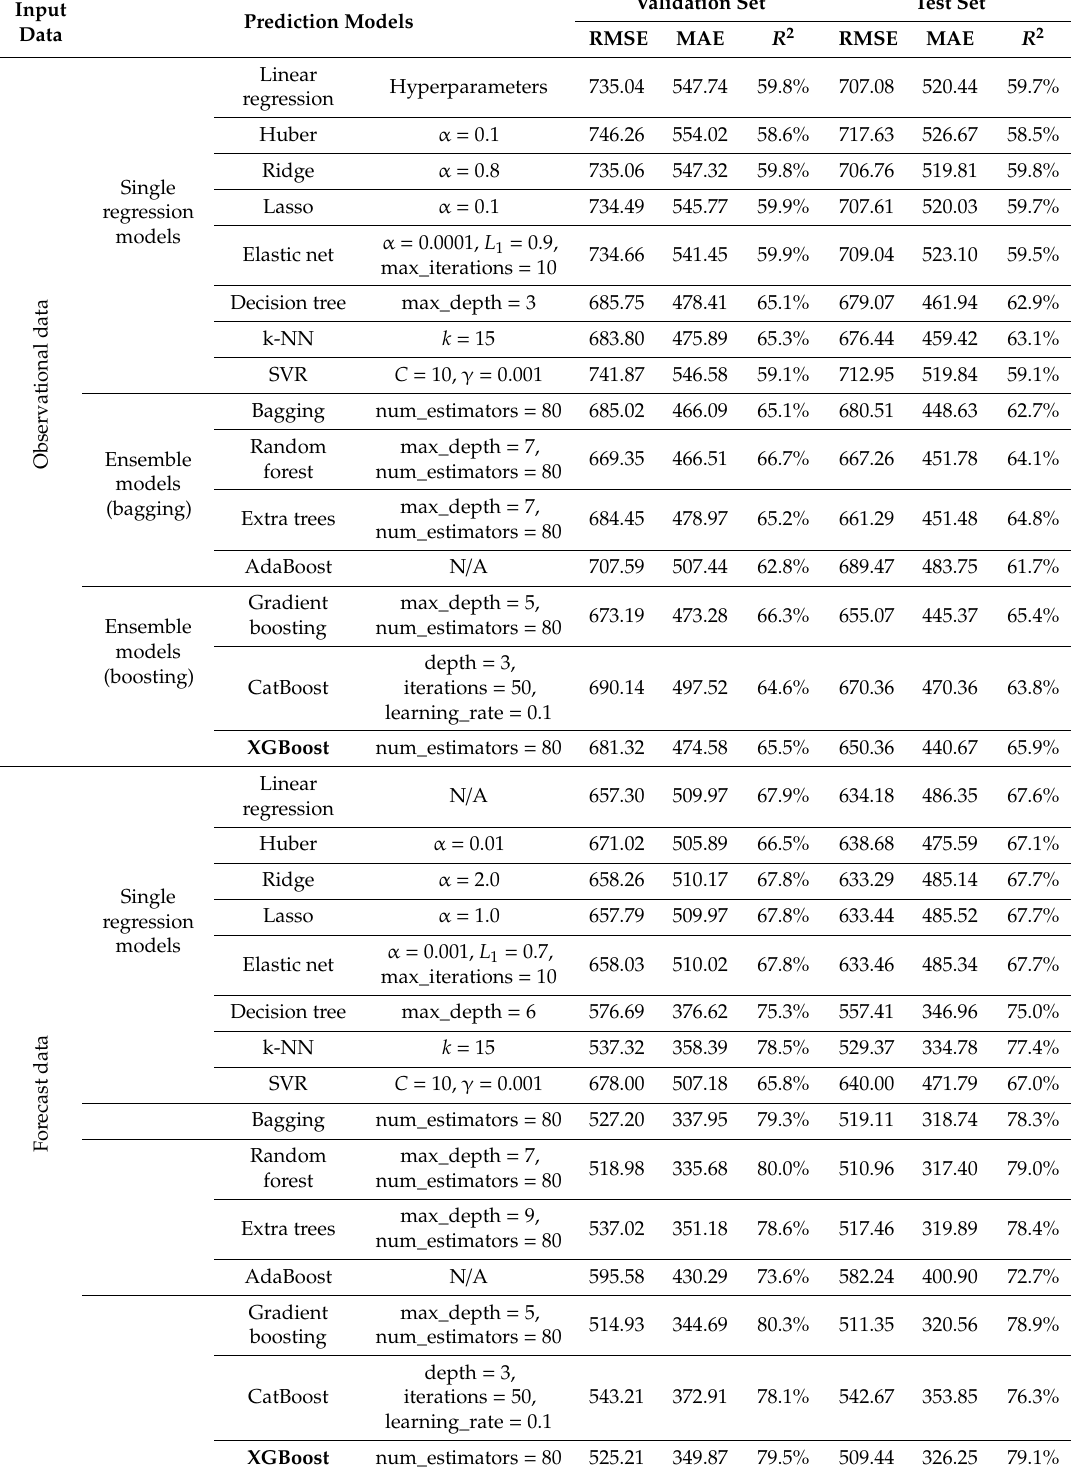
Table A2. Performances of solar power prediction